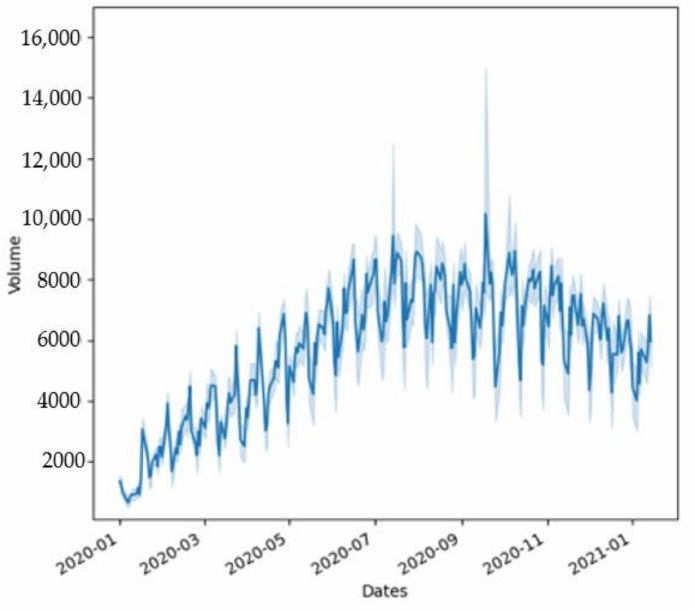
Figure 9. Shows German average traded volumes per day in Intraday markets. The light blue shadow represents the 95% confidence level. Figures 9 and 10 got generated using the same code in